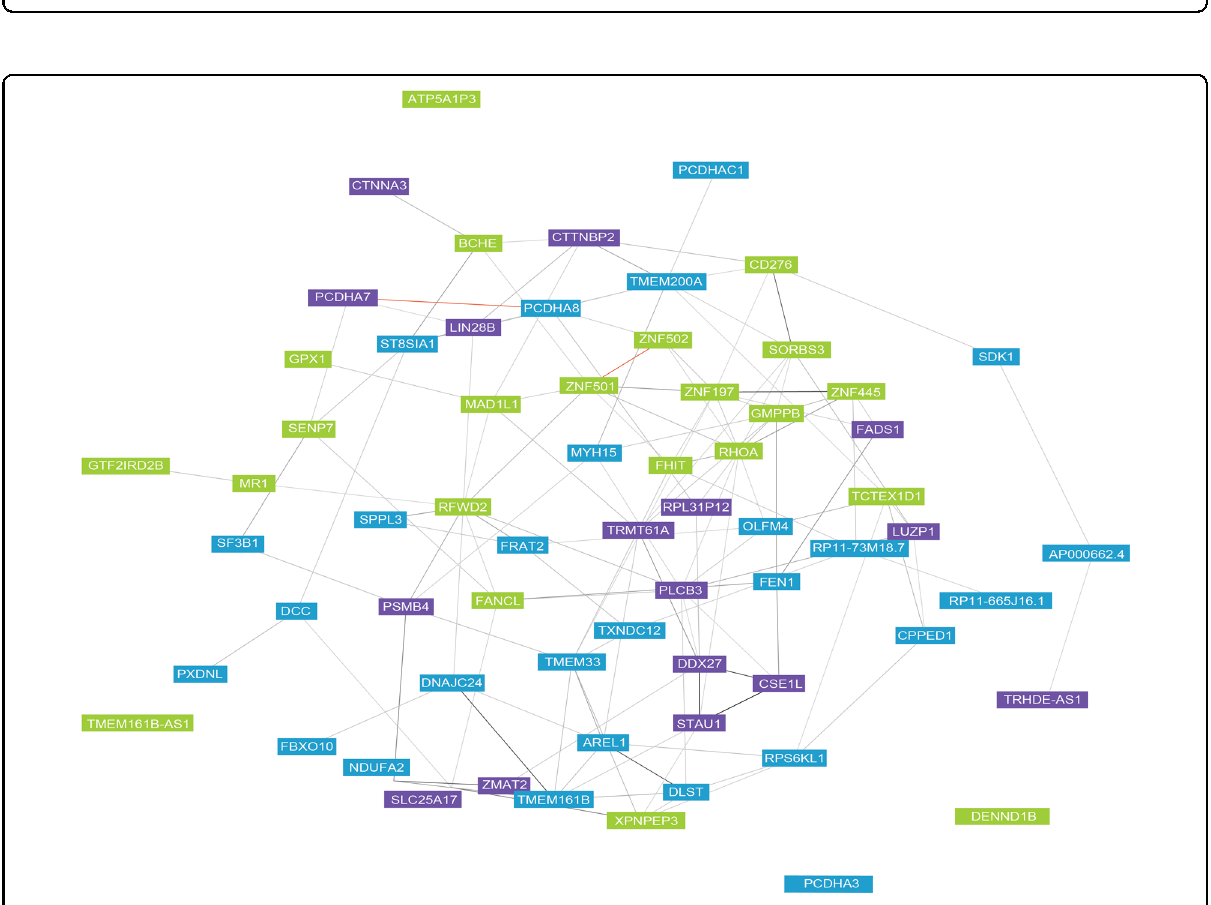
Fig. 3 Gene clustering for the identi fi ed TWAS genes based on co-expression. Public RNA-sequencing data from 31,499 samples was used to determine co-expression pro fi les. Co-expression cluster 1 was showed in blue. Co-expression cluster 2 was showed in green. Co-expression cluster 3 was showed in purple. Darker lines represent stronger